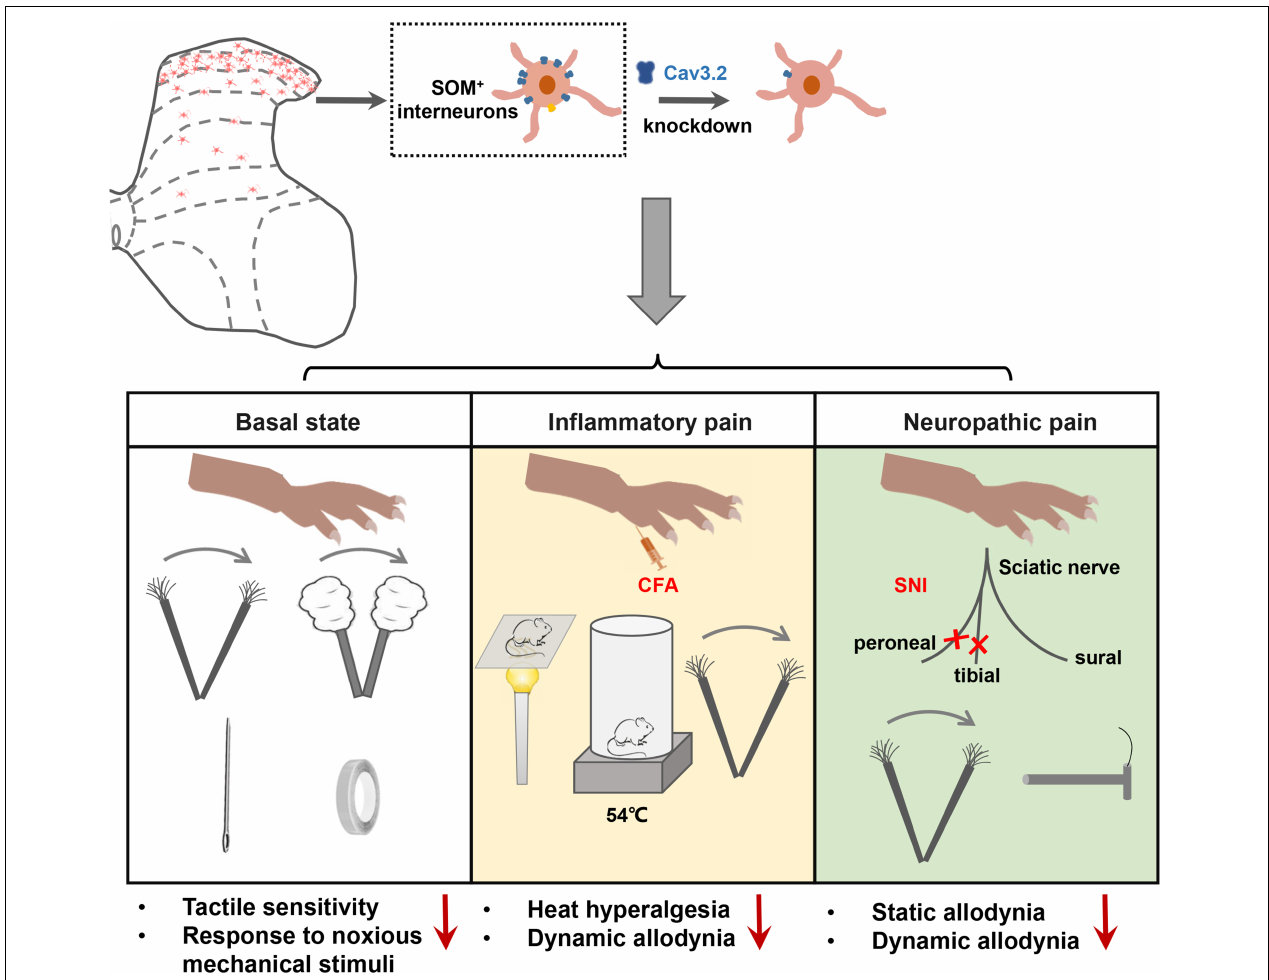
FIGURE 8 | Cav3.2 channels in spinal SOM + neurons are involved in the sensory processing of light touch in the basal state and contribute to heat hyperalgesia and mechanical allodynia in pathological pain, including inflammatory pain and neuropathic pain. In the current work, we demonstrated that the Cacna1h gene was enriched in SOM + neurons in the spinal dorsal horn. After knockdown of Cacna1h expression in spinal SOM + neurons by intraspinal injection of Cre-dependent virus, the mice displayed a lower response to light touch, including brush, cotton and tape stimulation, and showed a decreased response to the noxious mechanical stimulation in the basal state. In the pathological state, knockdown of Cacna1 h in spinal SOM + neurons attenuated thermal hyperalgesia and dynamic mechanical allodynia behaviors in the inflammatory pain model and both dynamic and static mechanical allodynia behaviors in the neuropathic pain